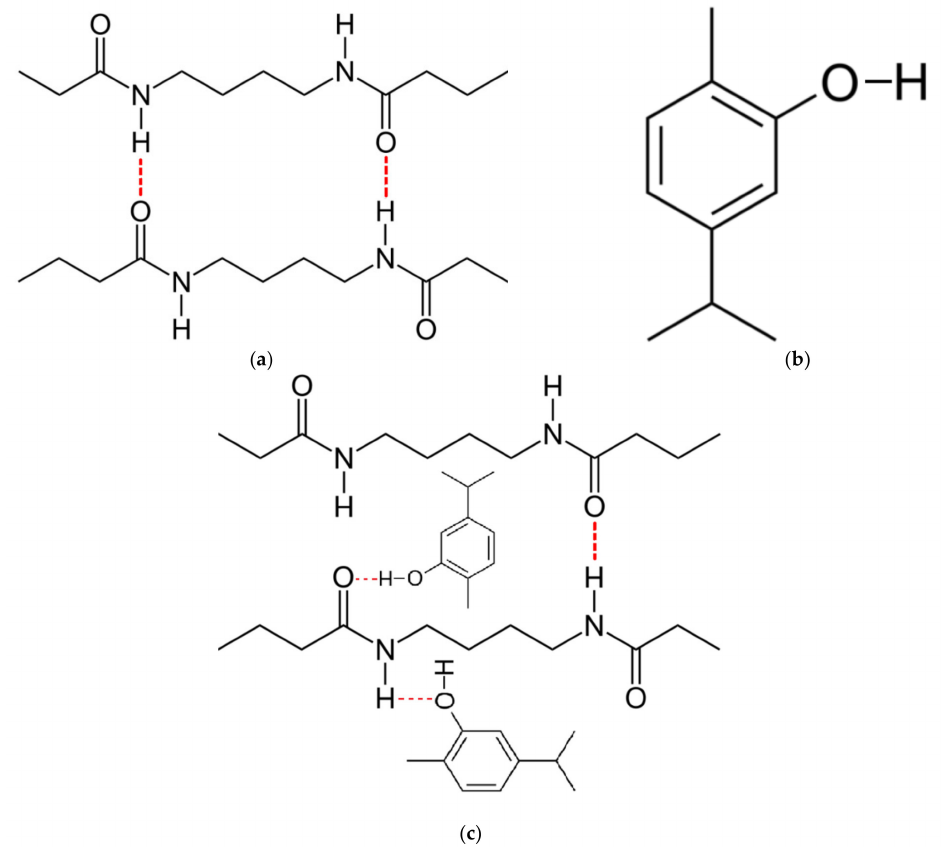
Figure 3. Chemical formulas of polyamide with hydrogen bonds between polymer chains shown in red ( a ) and carvacrol ( b ); possible hydrogen bonding in carvacrol-impregnated polyamide ( c